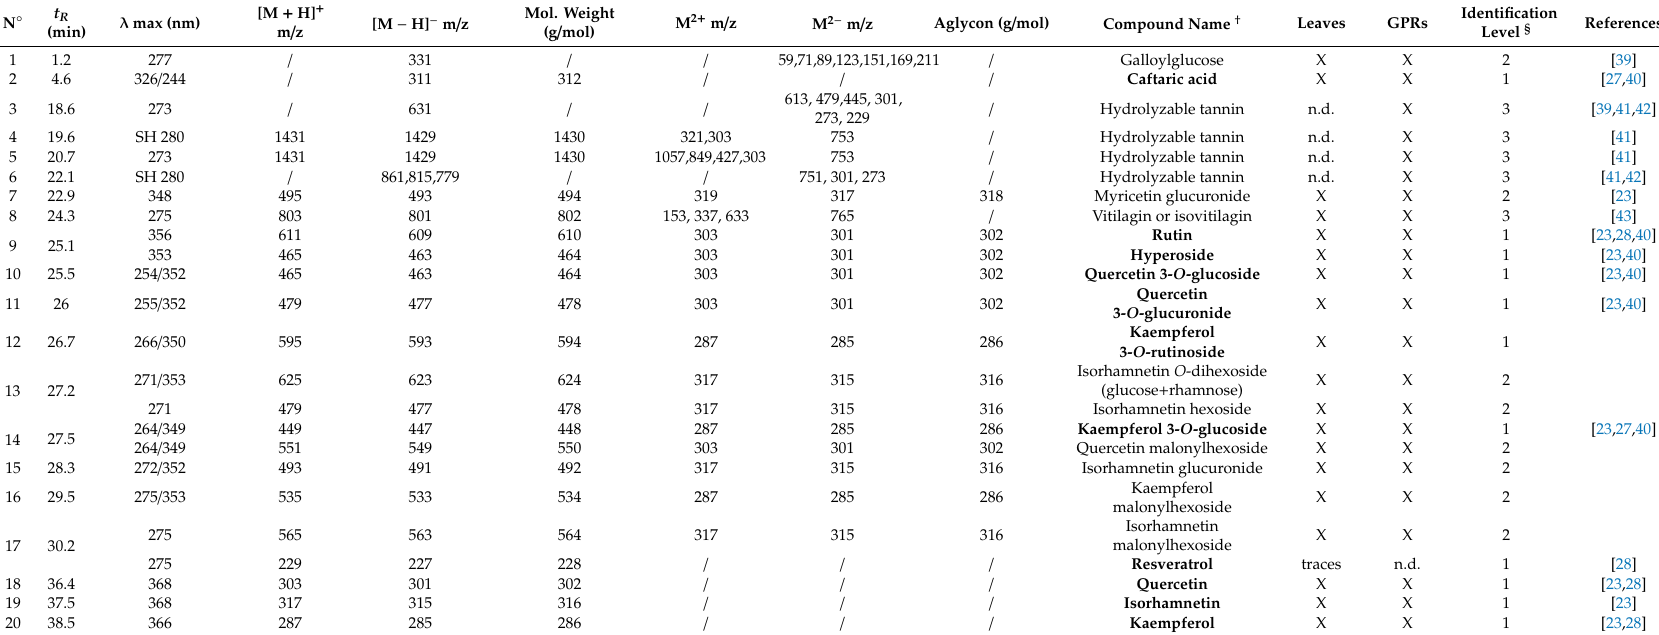
† In bold, the name of the compounds identified by comparison with authentic commercial reference standards. § Identification confidence as stipulated by the CAWG:46: Level 1, identified compound (a minimum of two independent and orthogonal data, such as retention time and mass spectrum) compared directly relative to an authentic commercial reference standard; Level 2, putatively annotated compound (compound identified by analysis of spectral data and / or similarity to data in a public database); and Level 3, putatively characterized compound class